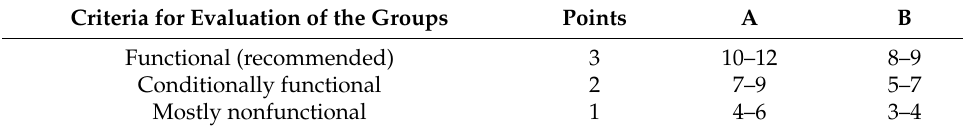
Table 2. Scheme of the reference point scoring system for linear element classification. Criteria for Evaluation of the Groups